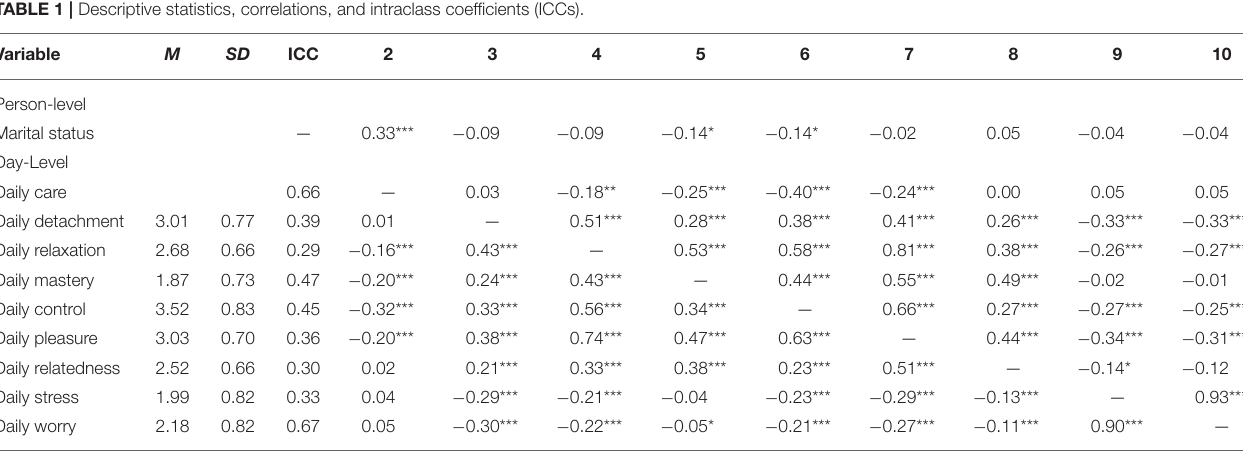
TABLE 1 | Descriptive statistics, correlations, and intraclass coefficients